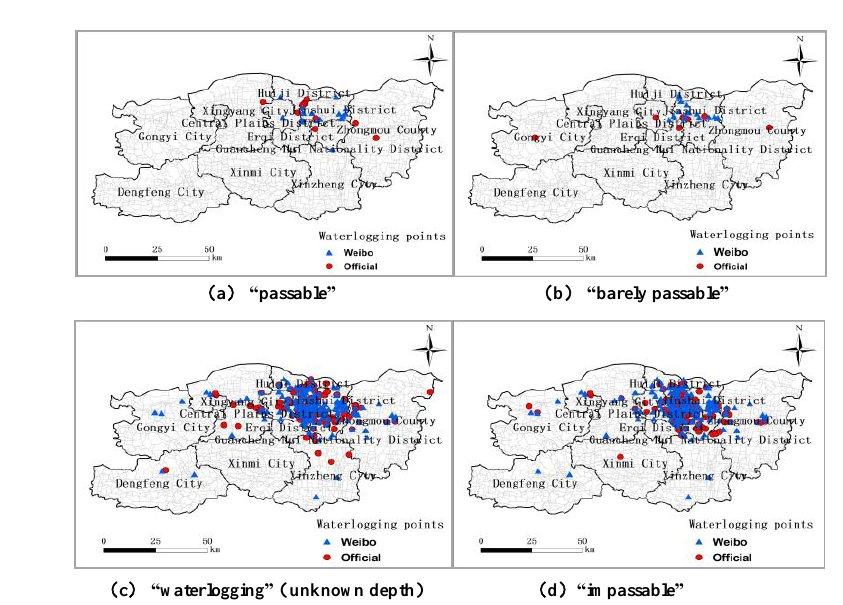
Figure 2. Waterlogging points’ comparison between Weibo and official.